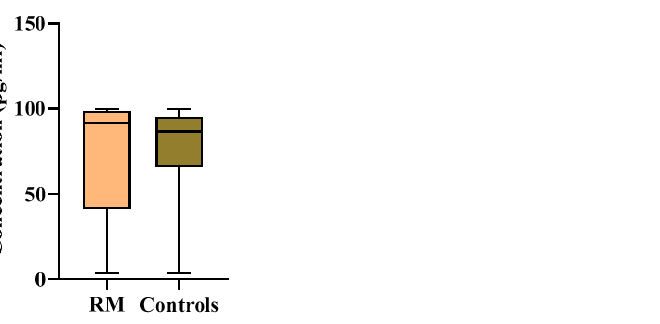
Figure 6. Box and Whisker plot showing serum IL17A concentration (case vs. control).